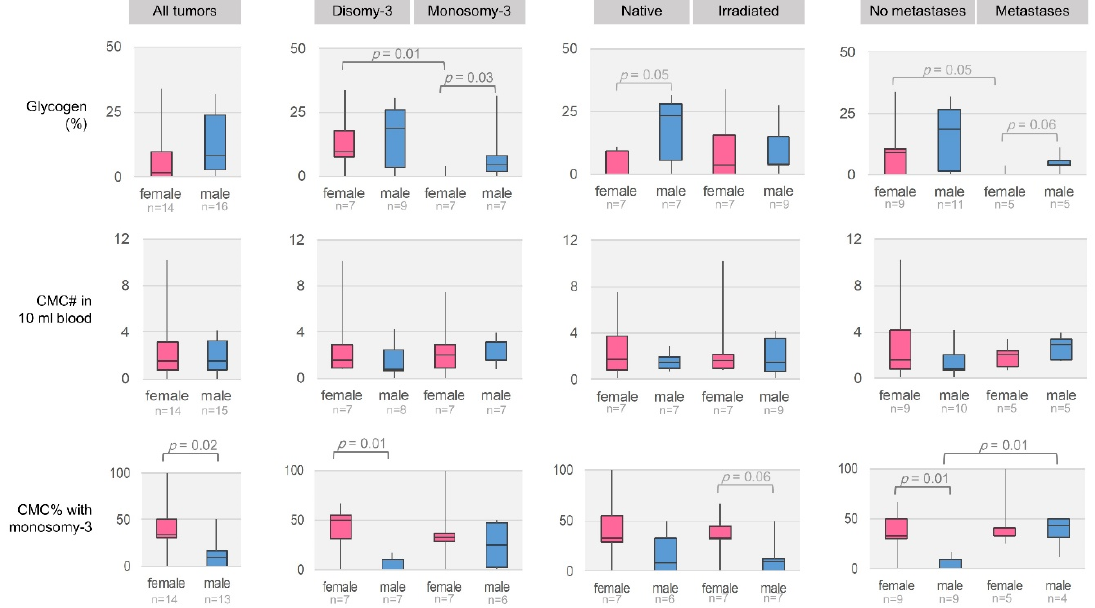
Figure 7. Comparison of the glycogen levels and CMCs in the female versus male patients with regard to the monosomy-3 status, irradiation, and metastases. p -Values were determined by the Mann-Whitney U test. N = number.